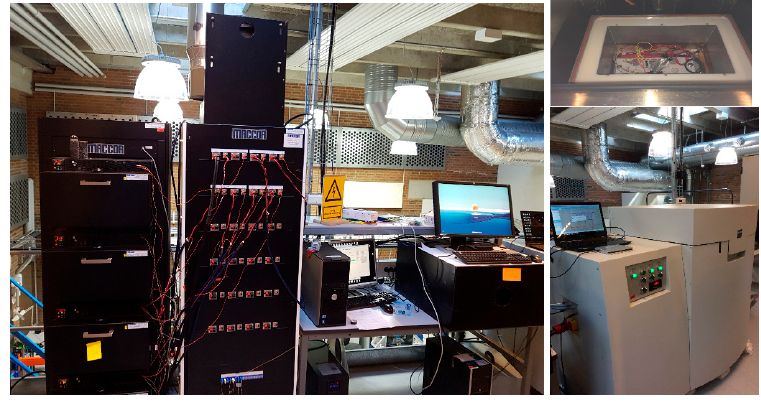
Figure 10. Experimental setup.